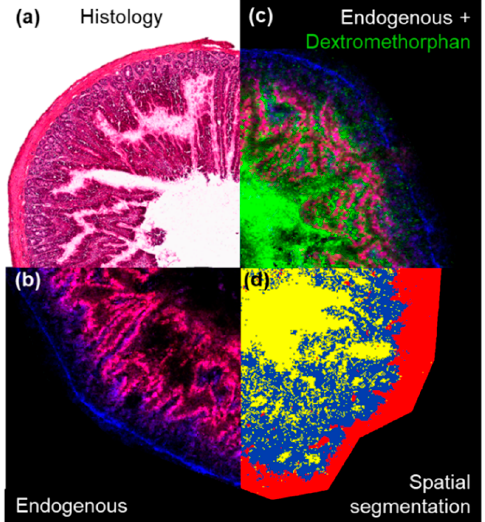
Figure 4. Extraction of the region-specific drug abundances in the different morphological features of the intestine: ( a ) The H&E stained tissue shows the typical morphology of a representative intestine section. ( b ) Shows the tissue outline determined by MALDI-MSI performed on an adjacent tissue section (endogenous lipids PC (34:2) [M+K] + ( m/z 796.53) (red) and PC (34:1) [M+K] + ( m/z 798.54) (blue). ( c ) Shows the relative localization of dextromethorphan ( m/z 272.20) within the tissue. ( d ) Shows the result of the spatial segmentation bisecting K-means clustering of the tissue performed on features detected between m/z 750 to 850. Yellow = intestinal lumen, blue = mucosa and red = unresolved mixture of mucosal crypts, submucosa and muscularis respectively.